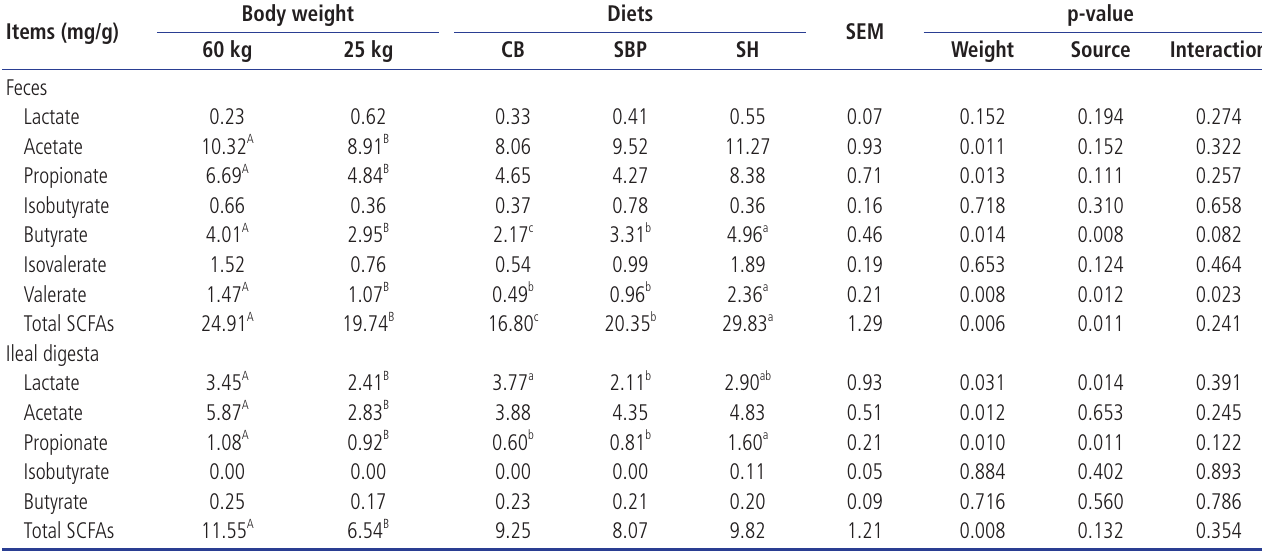
Table 8. Effects of pig body weight and fiber sources on short chain fatty acids (mg/g) concentration in the fresh ileal digesta and feces of pigs